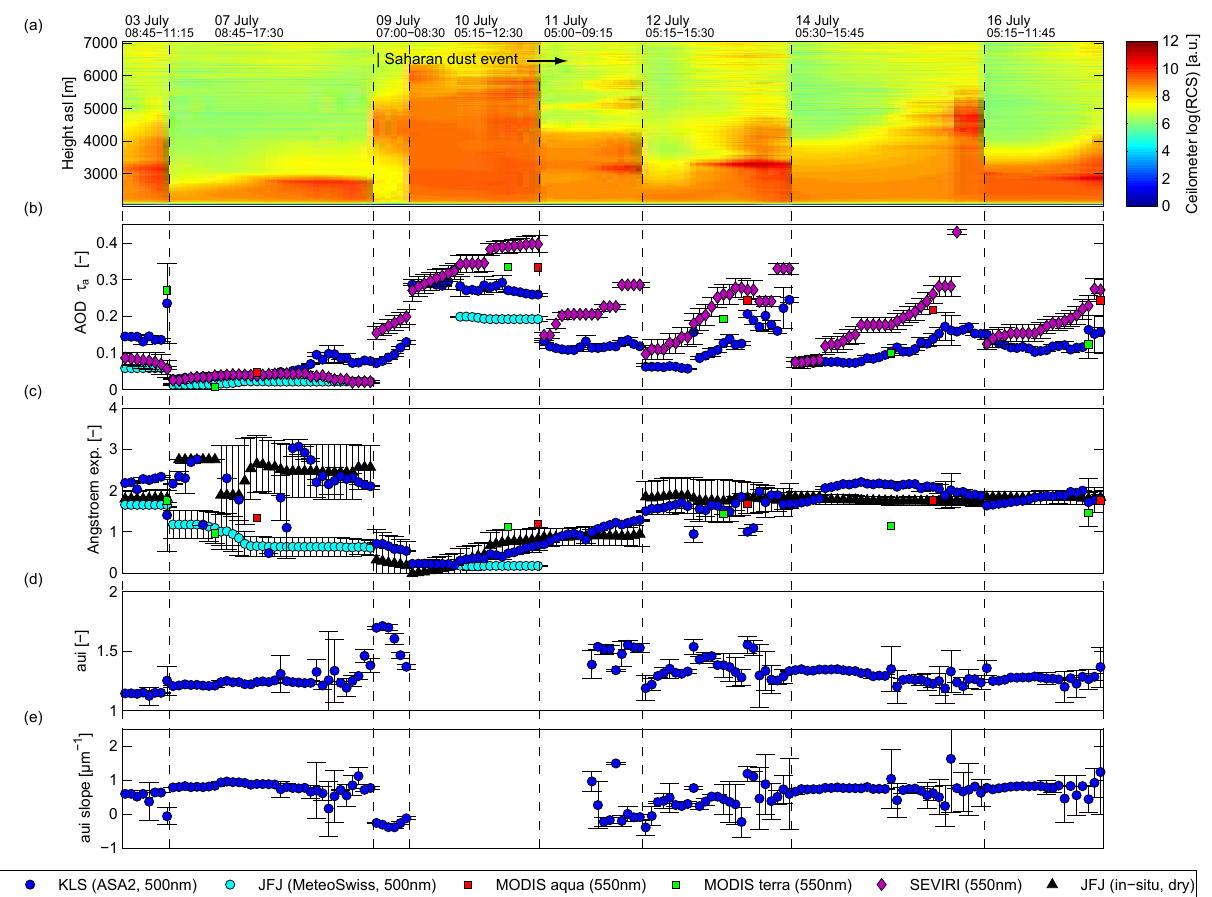
Fig. 9. Time series of remote sensing measurements (15-min averages during cloud-free daytime periods, error bars denote the standard deviation). (a) Range corrected signal of the ceilometer (Kleine Scheidegg, KLS); (b) aerosol optical depth (AOD) measured by FUBISS- ASA2 (Kleine Scheidegg, dark blue bullet points), by the Sun photometer of MeteoSwiss (Jungfraujoch, cyan bullet points), and retrieved from MODIS Terra and Aqua (squares), and MSG/SEVIRI (violet diamonds); (c) ˚Angstr¨om exponent measured by the instruments as in (b) ; (d) aureole index aui (at λ = 500nm) of FUBISS-ASA2; (e) spectral slope of aui. No aureole data is available for 10/11 July 2010 (due to signal saturation). Indicated is also the arrival of a Saharan dust plume on 9 July 2010. The satellite values are averaged over an 0 . 2 ◦ × 0 . 2 ◦